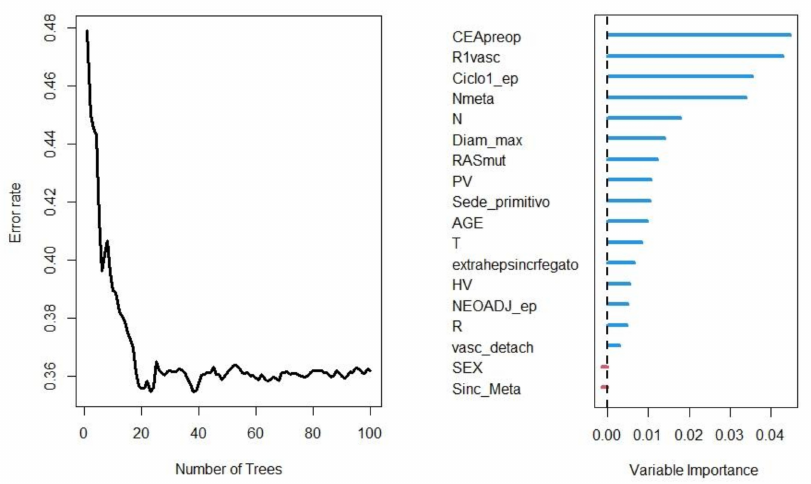
Figure 3. Error rates per each forest and the variables’ importance and the relative coefficient, obtained after the Random-Forest analysis.